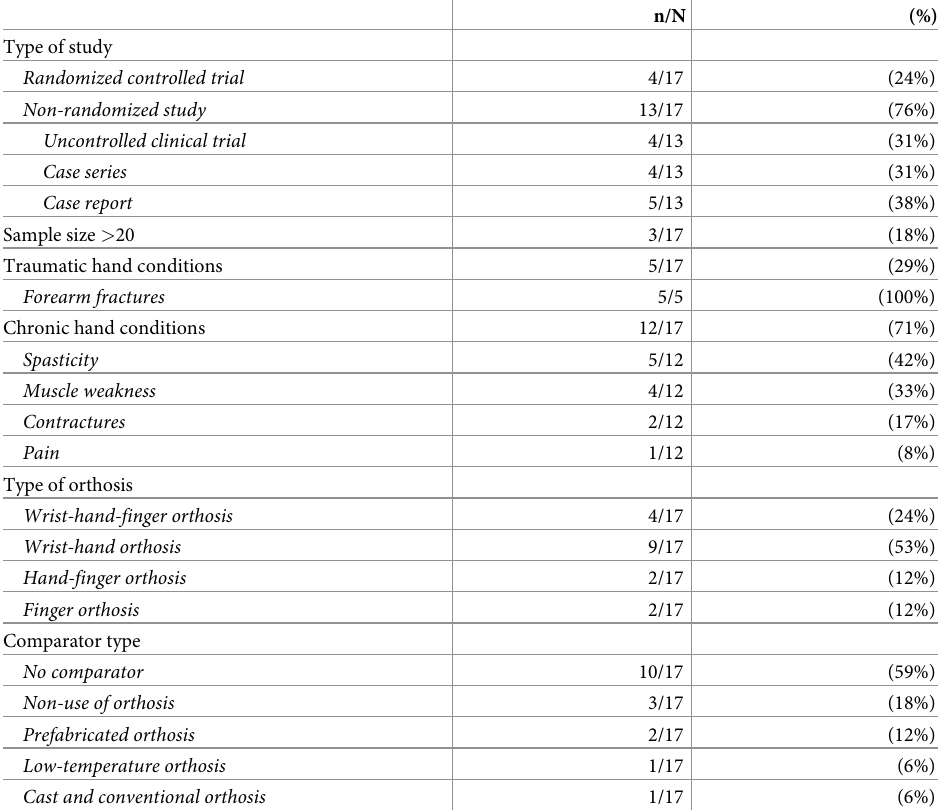
Table 1. Study characteristics